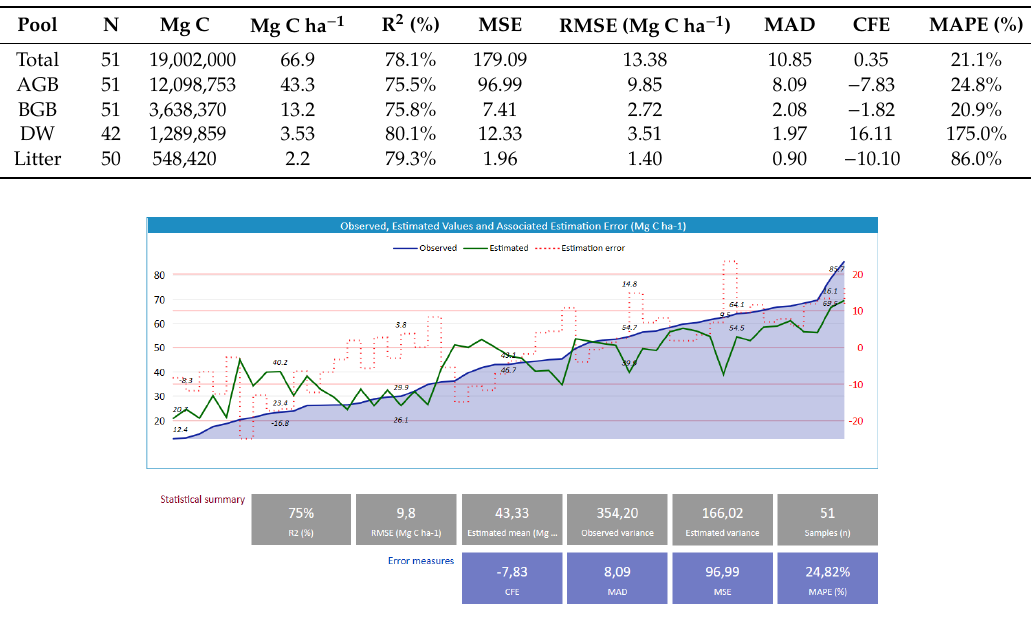
Figure 10. Carbon stored in the pine forests in 2018—a statistical summary and the error measures used to evaluate the performance of the model via random forest modeling. Table 7. Results of the accumulated carbon stocks and carbon stock models for the different pools in each protected area category.